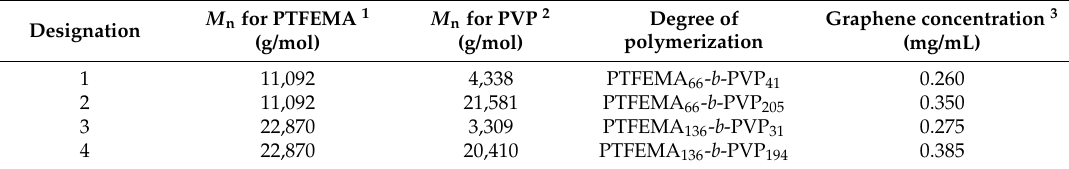
Table 1. The number average molecular weights and degrees of polymerization of PTFEMA- b -PVP block copolymers and the graphene concentrations from the supernatant solution of highly-ordered pyrolytic graphite (HOPG) dispersions with corresponding block copolymers.